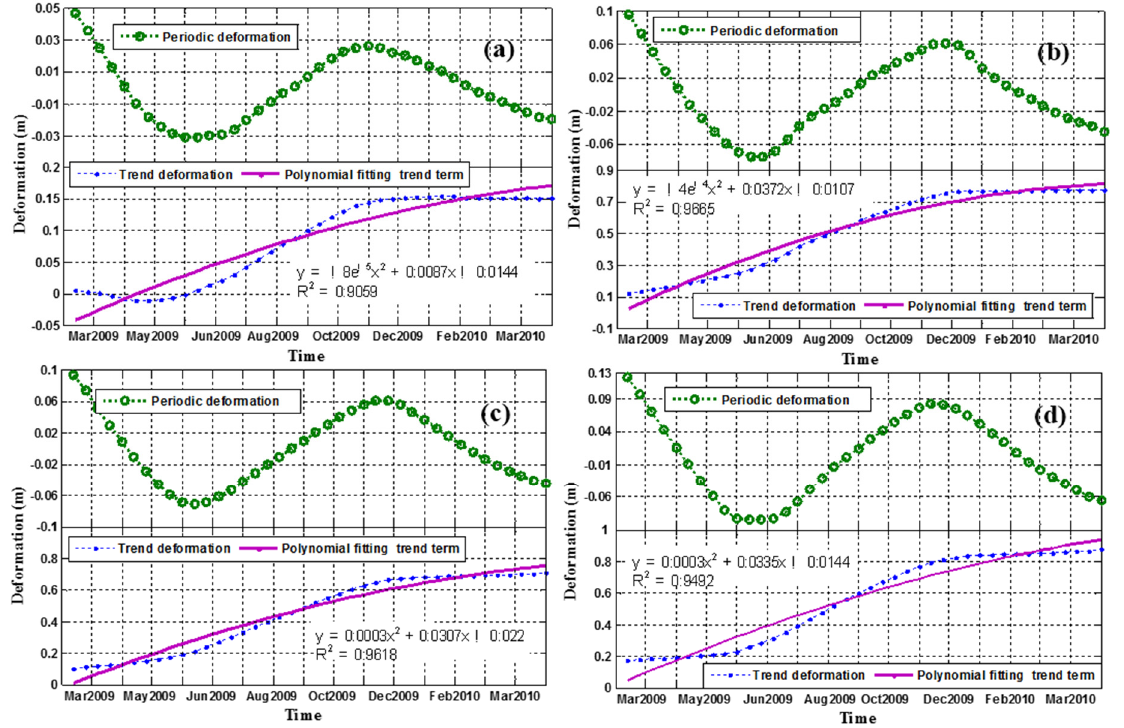
Figure 10. The decomposition results of CR2 and CR14 using the moving average method; ( a , b ) are range and azimuth results of CR2; ( c , d ) are range and azimuth results of CR14.